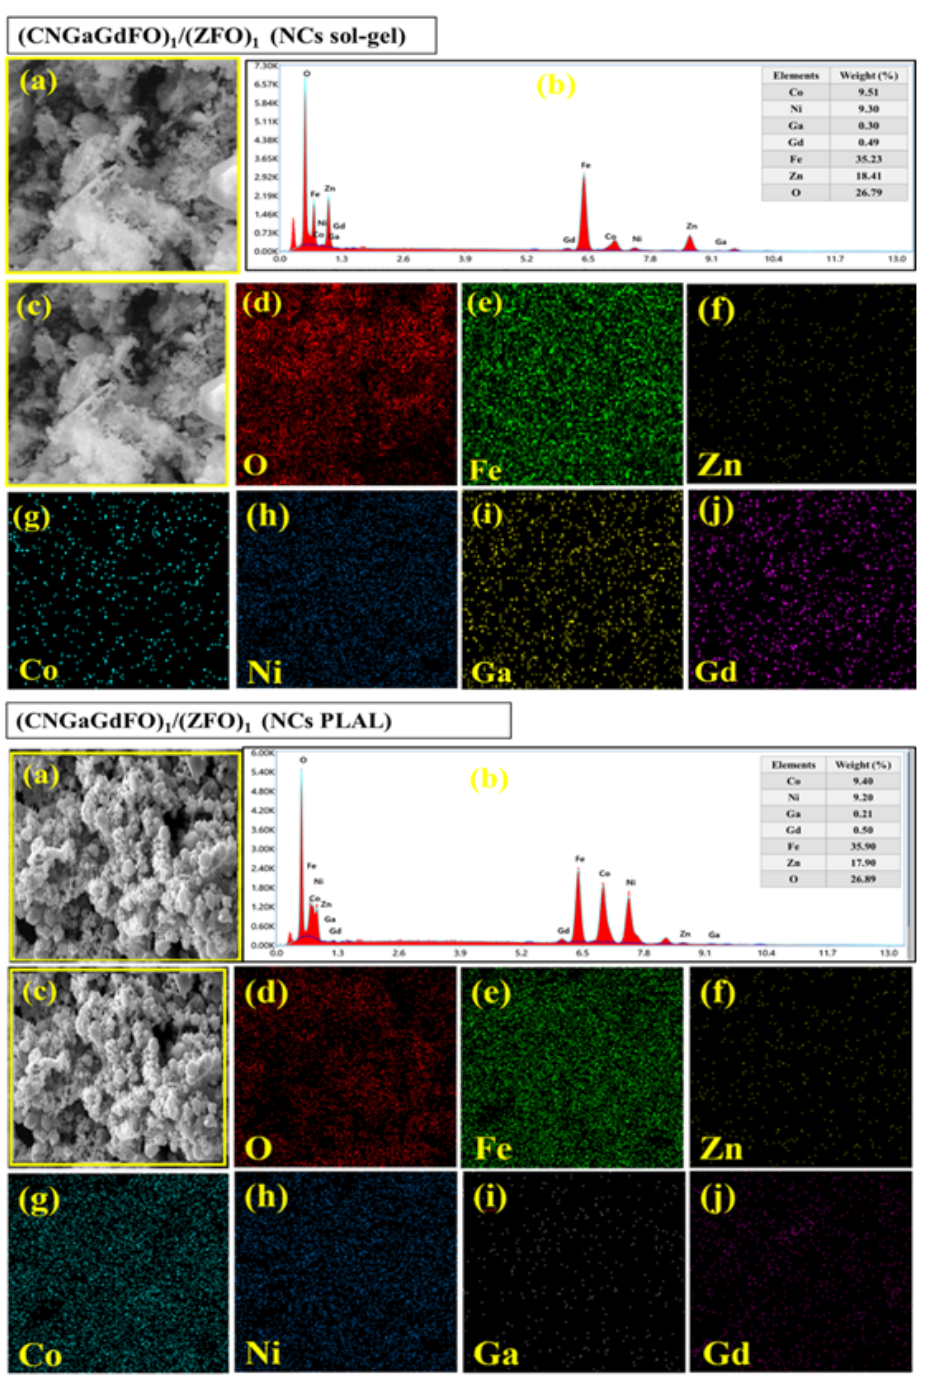
Figure 3. EDX and elemental mapping (EM) of (CNGaGdFO) x /(ZFO) y ( x:y = 1:1) NCs prepared by sol-gel (top) and PLAL (down): (a) general SEM image; (b) EDX spectra; (c) detailed SEM image for EM; (d) oxygen distribution on EM; (e) Fe distribution on EM; (f) Zn distribution on EM; (g) Co distribution on EM; (h) Ni distribution on EM; (i) Ga distribution on EM; (j) Gd distribution on EM